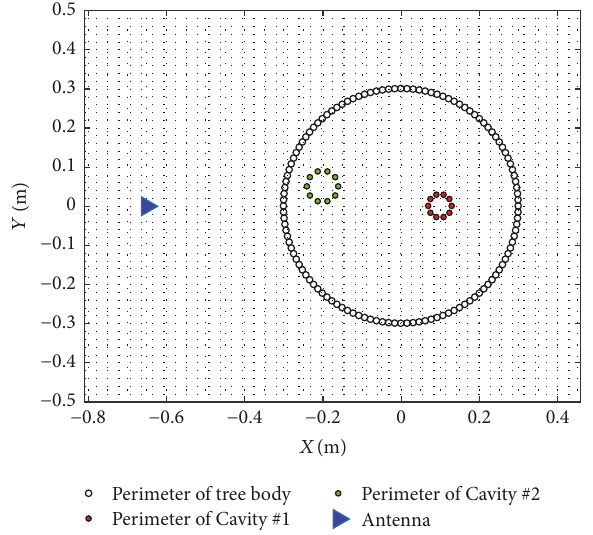
Figure 2: Simulation geometry for the TIIR